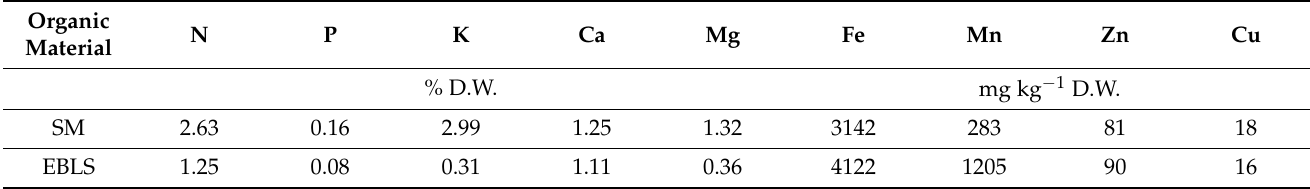
Table 1. Nutrient contents of the two organic amendments applied to the control